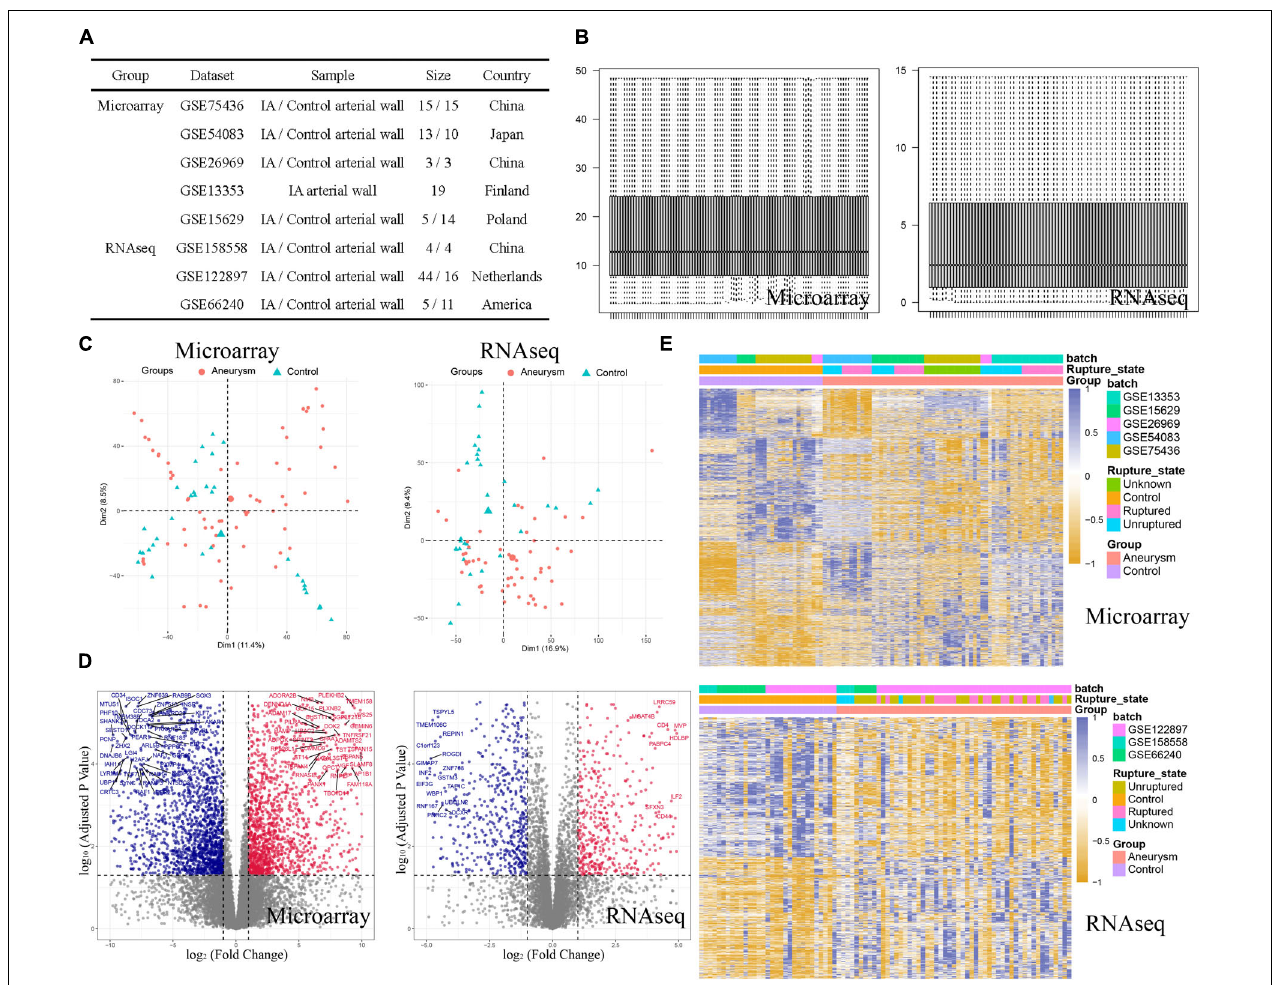
FIGURE 2 | Data preprocessing and DEG screening in both training and validating cohorts. (A) Basic information of included dataset. (B) Boxplots of normalized data showed similar distributions of different samples. (C) PCA plots showed the IA group could be discriminated from the controls. (D) Volcano plots visualized the fold change and P -value of all genes between the two groups. Red plots were upregulated genes and blue plots were downregulated genes. (E) Heatmaps visualized the expression level of